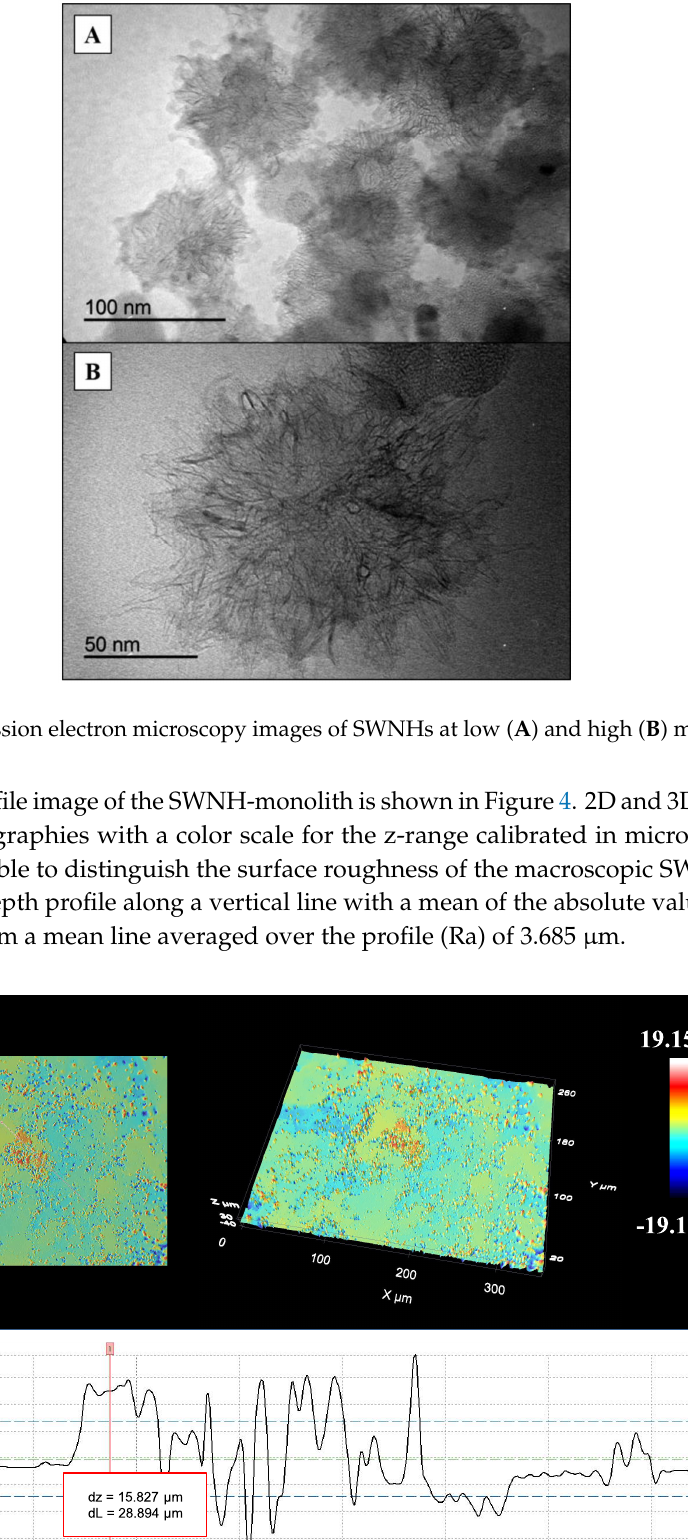
Figure 4. 2D and 3D images of the SWNH-monolith ( A ), and its depth profile ( B ) in confocal microscopy.